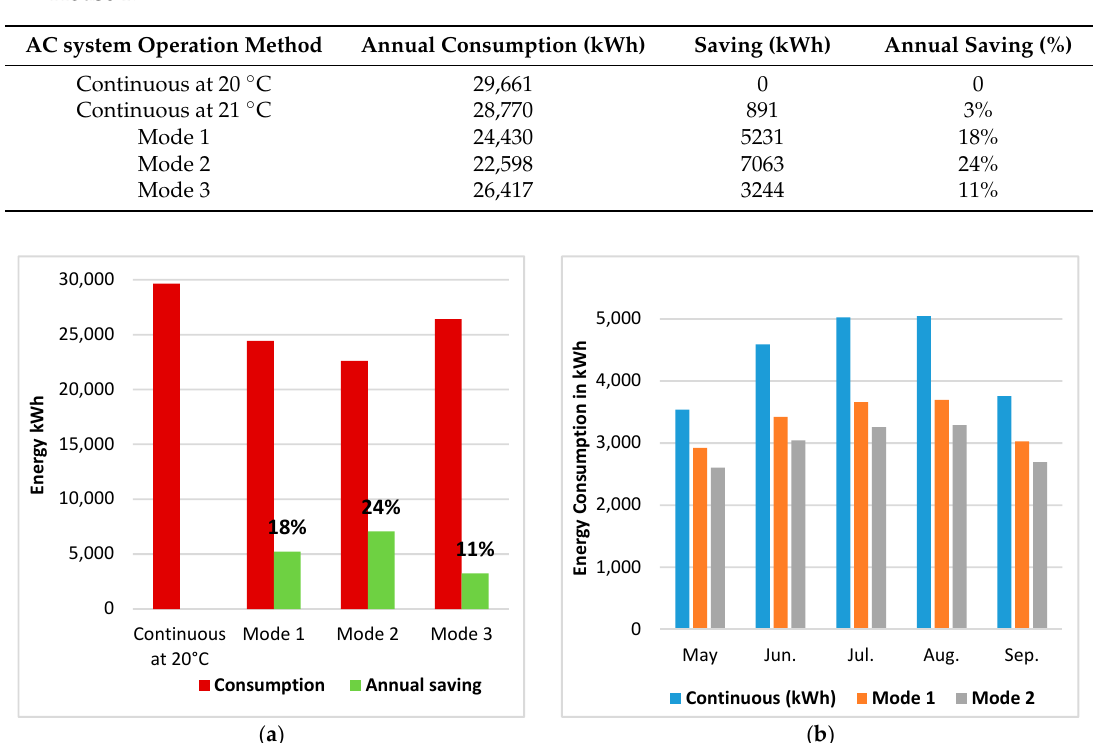
Table 3. Annual energy consumption under the continuous and different modes of AC operation for House 1.